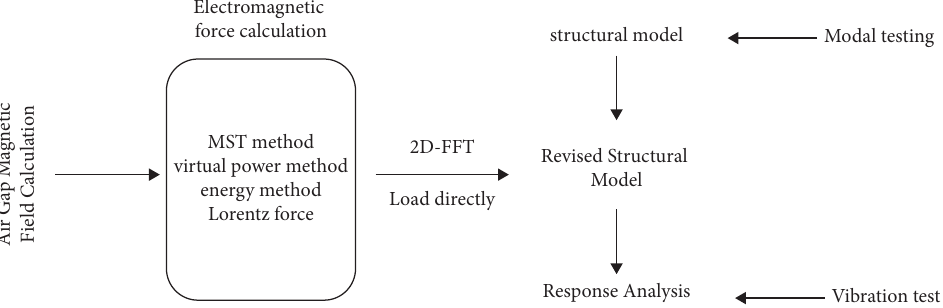
Figure 3: Basic fow of electromagnetic vibration